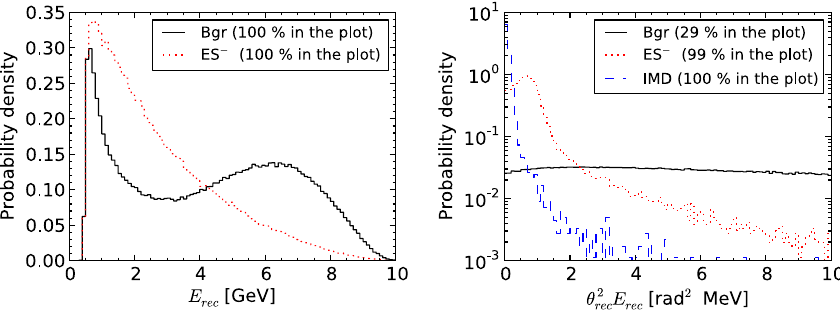
FIG. 10. Left: Distribution of measured total electromagnetic energy for ES (cid:1) (red) and background (black) events in the (cid:3) (cid:1) decay mode of a 10 GeV neutrino factory. Right: Distribution of the reconstructed (cid:1) 2 ‘ E ‘ variable for the scattered track for IMD (blue), ES (cid:1) (red), and background (black) events in the (cid:3) (cid:1) decay mode of a 25 GeV neutrino factory. The fraction of events contained in the plot is indicated in the legend. All distributions are normalized to a unit